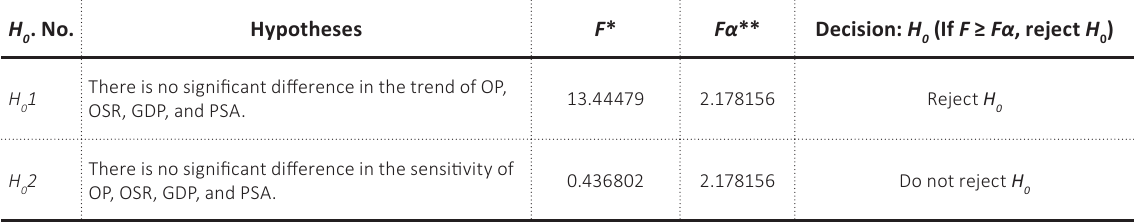
1 ) and CBI ( H 2 ) of OP, OSR, GDP, and PSA (as given in Appendices A1 and A2) and ** F taken from the 0 0